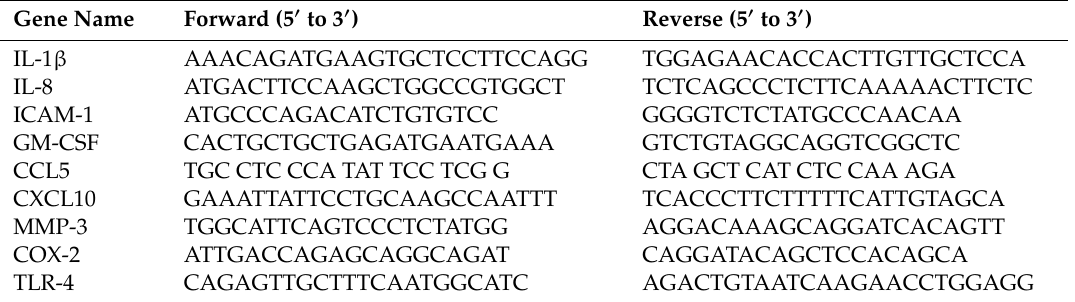
Table 1. List of the sequence of gene